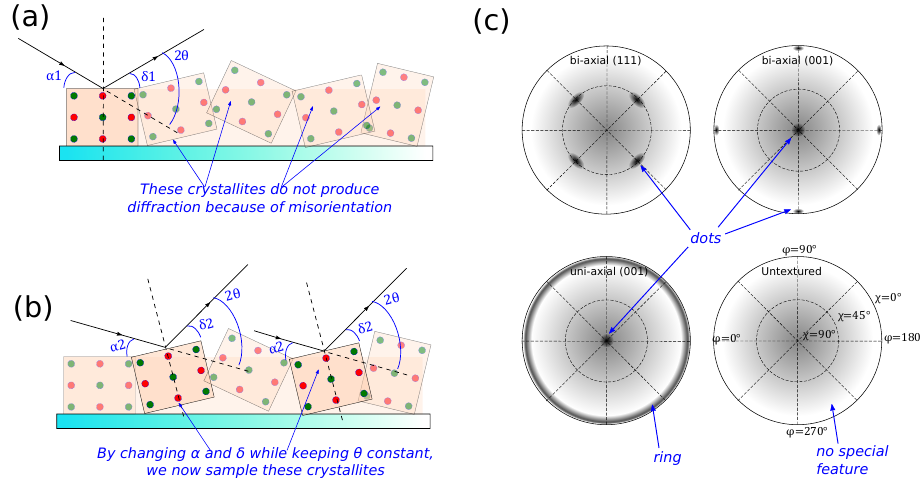
Figure 4. Illustration of how a pole figure works. ( a ) for a given set of θ , α , and δ , only some crystallites in the sample produces diffraction. Other crystallites do not satisfy either Bragg condition, i.e., are misoriented. ( b ) By keeping θ constant but changing α , and δ , one may sample other misoriented crystallites with the same Bragg condition. ( c ) Examples of how pole-figure data would look for the textures given on Figure 1b. The angles χ and φ are as defined in Figure 3. Because of the thin-film nature of the sample, expect some background from the sample substrate. For example, an amorphous substrate (e.g., glass), will manifest in a low background that is strongest in the center ( χ = 90 ◦ ) and fading towards the edge ( χ = 0 ◦ ). Similarly, polycrystalline samples with low texture exhibit no special features, while those with high texture will have dots. As such, a sample with uni-axial texture will have combinations of dots and